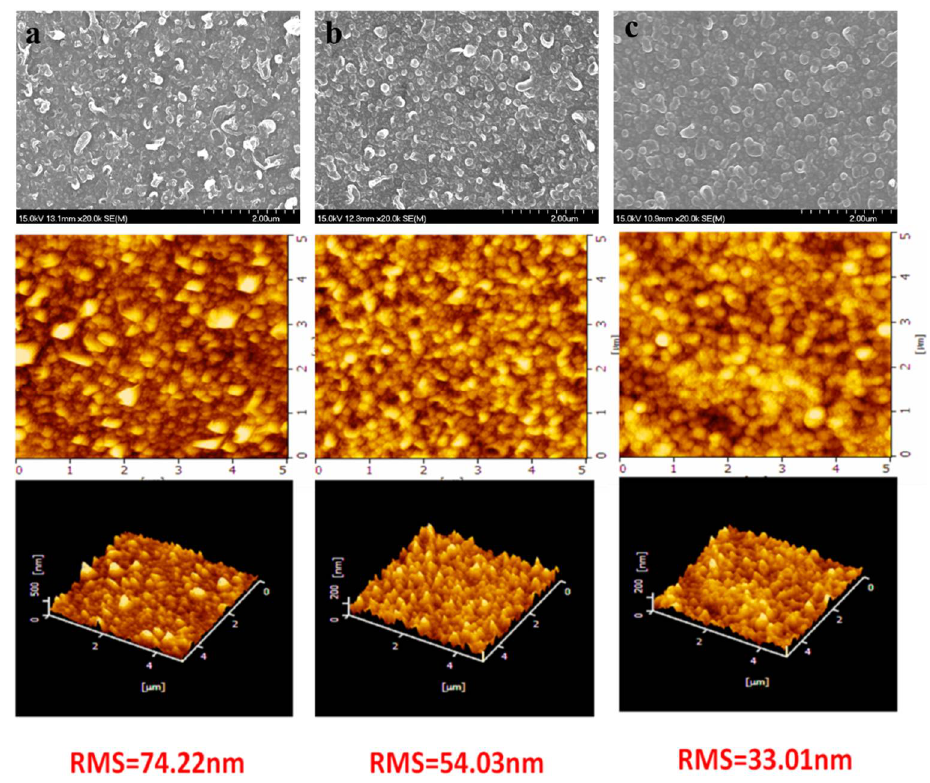
Figure 5. SEM (first line) and AFM images (second and third line) of ( a ) PAUt membrane; ( b ) PAUt-CS membrane and ( c ) PAUt-PDDA/PSS/CS membrane, respectively.